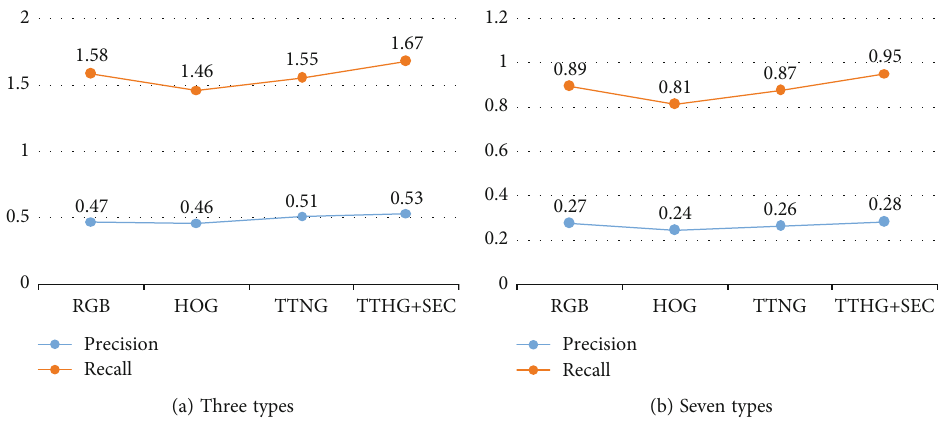
Figure 8: Precision and recall on di ff erent data sets. Table 2: Confusion matrix after multifeature